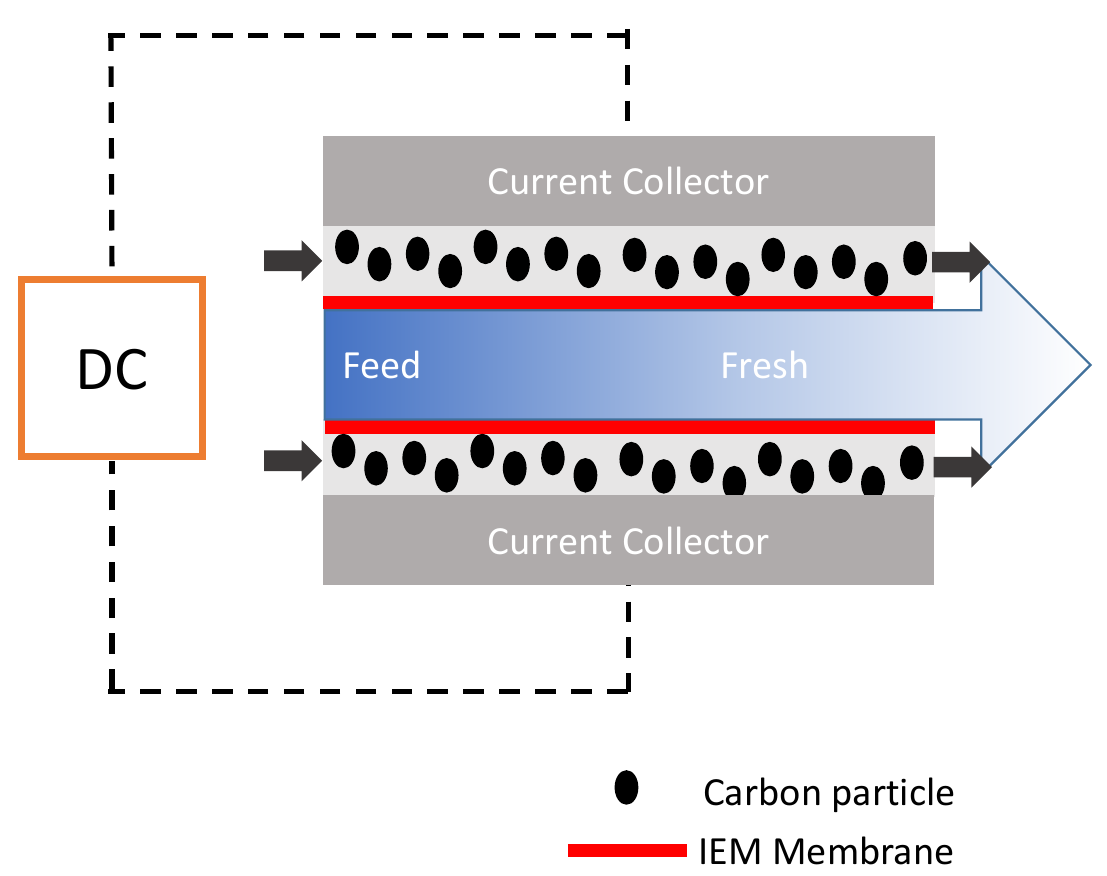
Figure 8. Schematic representation flow capacitive deionization (FCDI) system.